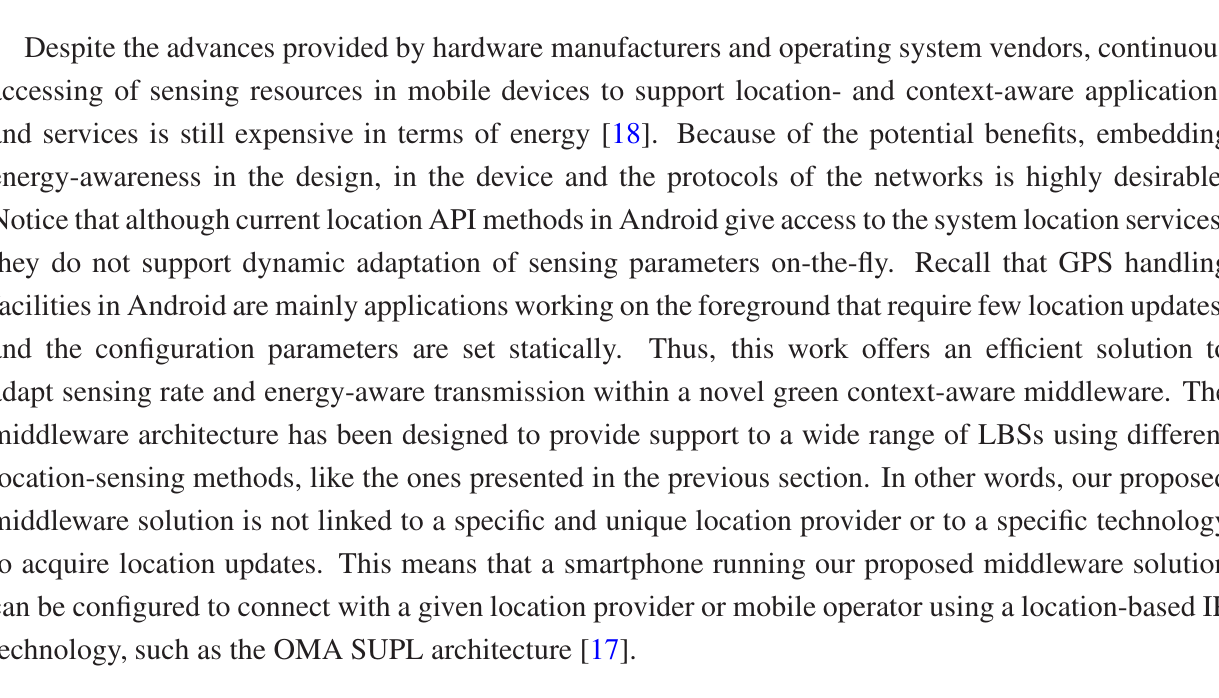
Figure 1. Middleware architecture for context-aware and energy-efficient sampling and transmission of data sensor